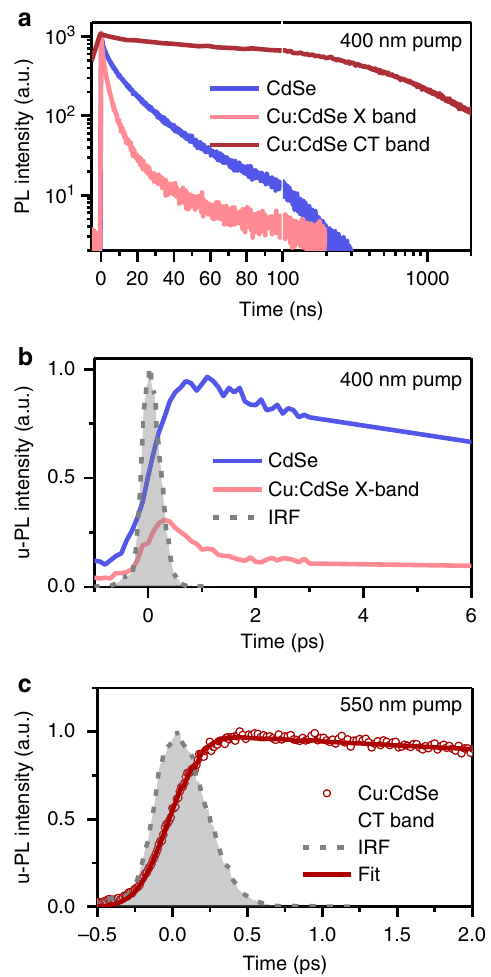
Fig. 3 Femtosecond hole capturing in Cu-doped QDs. a Time-resolved PL kinetics for CdSe QDs (blue) and X (light red) and CT (dark red) bands in Cu:CdSe QDs. The fi rst 100 ns is in linear scale while the rest is in logarithmic scale. b u-PL kinetics for CdSe QDs (blue) and X band in Cu: CdSe QDs (light red) measured by femtosecond upconversion excited at 400 nm. The gray dashed line (shaded) is the IRF of the system (390 fs). c u-PL kinetics of the CT band of Cu:CdSe QDs excited at 550 nm (dark red circles) and its fi t (dark red solid line) by convoluting with the